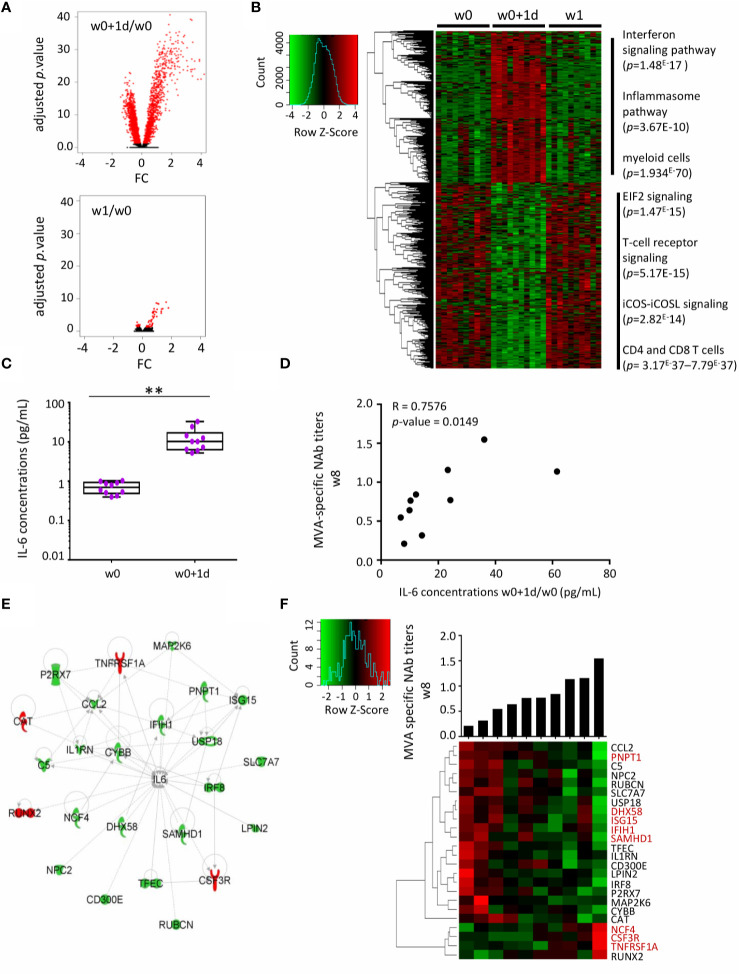
Serum IL-6 and related whole-blood genes one day after MVA-B vaccination related to MVA-Nab responses after i.m. immunization. (A) Volcano plots of the 2611 and 54 genes differentially expressed one day (w0+1d, upper panel) and one week (w1, lower panel), respectively, after MVA-B i.m. vaccination, compared with baseline (w0), according to the -log10(adjusted p-value) and log2FC. Significance is defined by an adjusted p-value < 0.05 (red). (B) The hierarchical clustering is based on the expression profiles of these significantly differently expressed genes (2611 + 54) at each of the three time points: w0 (n = 10), w0+1d (n = 10), and w1 (n = 10). The color-gradient from green (-4, low) to red (4, high) indicates gene expression levels (log2). The functional enrichment was performed with IPA software. p-values by IPA are indicated for each pathway. (C) Serum concentrations (pg/mL) of IL-6 at times w0 and w0+1d presented in box-and-whisker plots. The Wilcoxon test compares w0 to w0+1d, with a significant increase observed at w0+1d (**p < 0.01). (D) Correlation graph shows the significance of the difference between MVA-specific NAb titers at w8 (log1/EC50) and IL-6 serum concentrations at w0+1d/w0 (pg/mL). The Spearman test was applied, with significance defined by a p-value < 0.05. (E) IPA highest scored biological network for the 24 correlated genes (d1) involved in IL-6 signaling and correlated with MVA-Nab responses at w8. The downregulated genes in high responders are in green and the upregulated genes in red. (F) The hierarchical clustering is based on the fold-change expression profile (w0+1d/w0) of these 24 genes. The histogram shows MVA-NAb response intensity at w8 (log1/EC50) for each individual, from lower to higher responders. In red, genes in common with the literature (3, 8, 24).